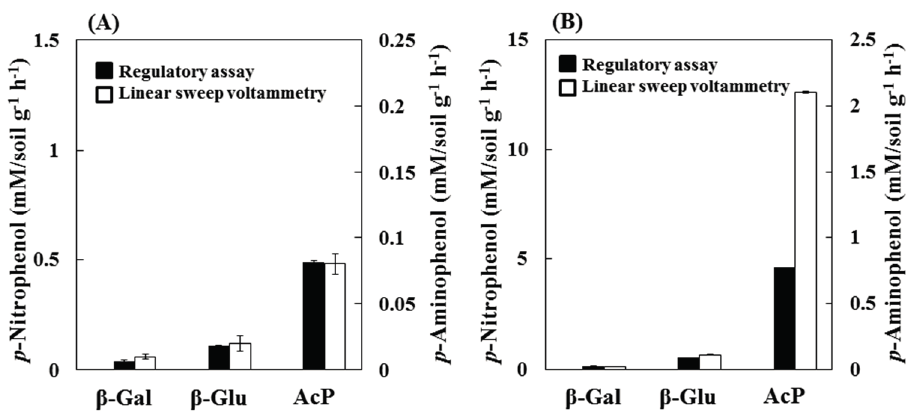
Figure 6. The β -gal, β -glu and AcP activities of ( A ) soil A and ( B ) soil B obtained from regulatory assay and linear sweep voltammetry. Regulatory assay: mM PNP·soil g − 1 ·h − 1 at 37 °C, Linear sweep voltammetry: mM PAP·soil g − 1 ·h − 1 at 37 °C. Error bars represent standard errors ( N =